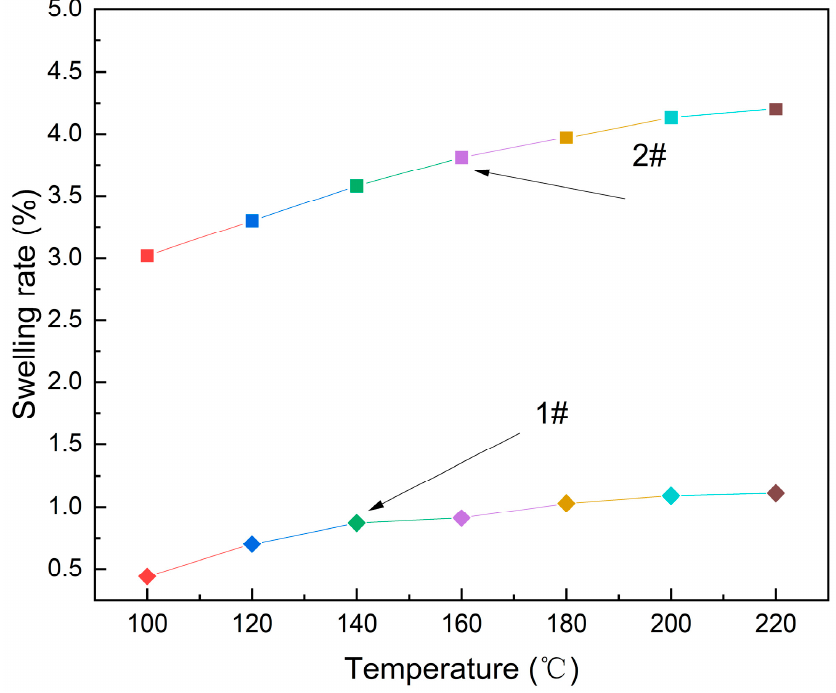
Figure 3. Swelling rater of different oil sands with temperature (1#, 2#).